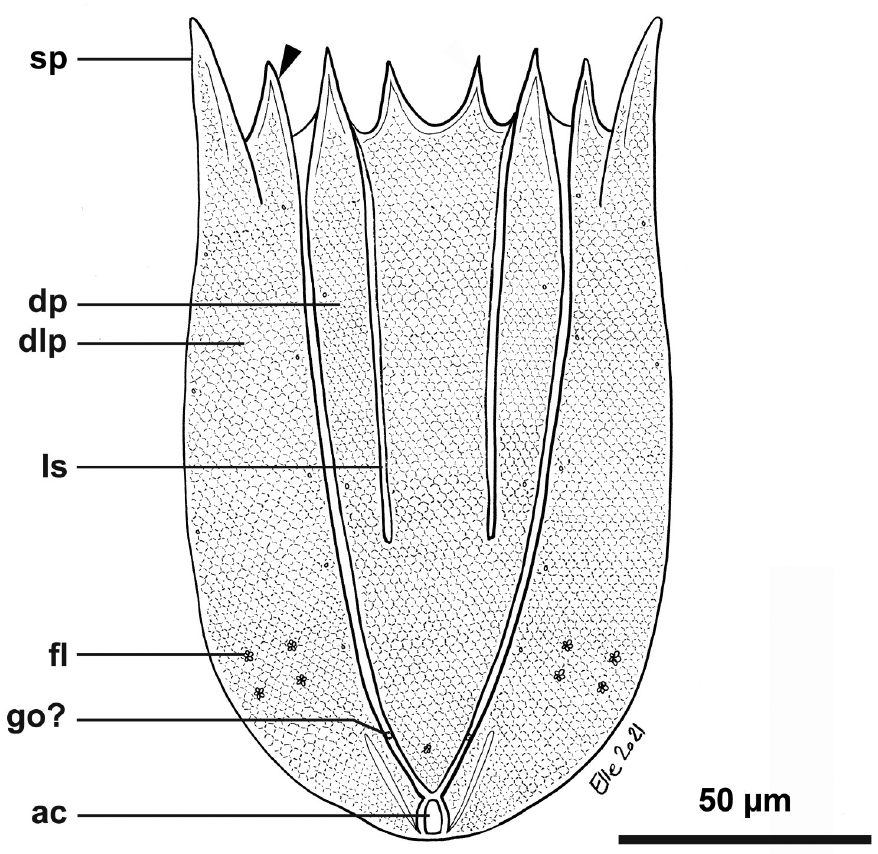
Fig 3. Line art drawing of the adult male partial habitus of Nanaloricus valdemari sp. nov. Dorsal view of the lorica, anterior faces up. Abbreviations: ac, anal cone; dlp, dorsolateral plate; dp, dorsal plate; fl, flosculum; go?, putative gonopore; ls, longitudinal stripe; sp (and arrowhead), anterior